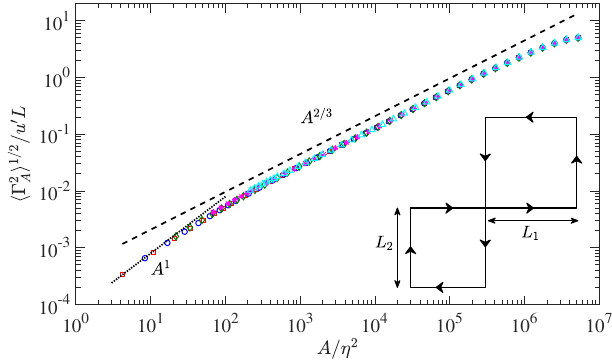
FIG. 3. Circulation standard deviation h Γ 2 A i 1 = 2 for two sets of contours with the same loop area and different aspect ratios (see insets to the upper left) as a function of the area, at R λ ¼ 1300 , computed on a 8192 3 grid. The standard deviations seem to be independent of the loop perimeter, especially for inertial loops (roughly, 10 3 ≤ A= η 2 ≤ 10 6 ). Inset on the bottom right plots the ratio of the standard deviation of the two contours as a function of loop area. The ratio is quite close to unity, though smaller by a few percent. It is also not exactly a constant within IR. We also show the same ratio for a lower Reynolds number, R λ ¼ 240 . It is clear from the two Reynolds numbers that, within the accuracy just noted, the area rule holds increasingly well at higher Reynolds numbers. The dashed line indicates the K41 law, h Γ 2 i 1 = 2 ∼ A 2 = 3 ; it holds adequately for inertial loops though A the actual least-squares fit gives a slope of 0.674 (which is about 1.2% higher).